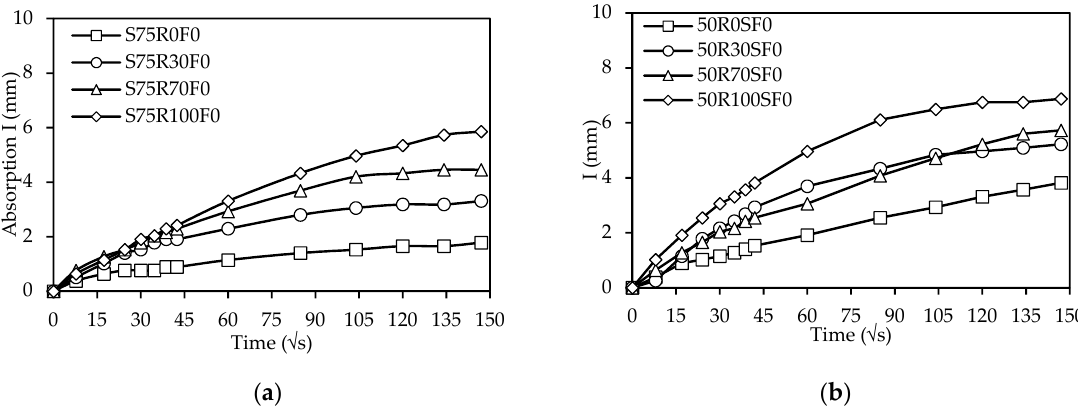
Figure 18. Typical capillary sorptivity of alkali-activated concrete with slag:fly ash ratio of: ( a ) 3:1; ( b ) 1:1. Typical absorption plots of alkali-activated concrete incorporating equal portions